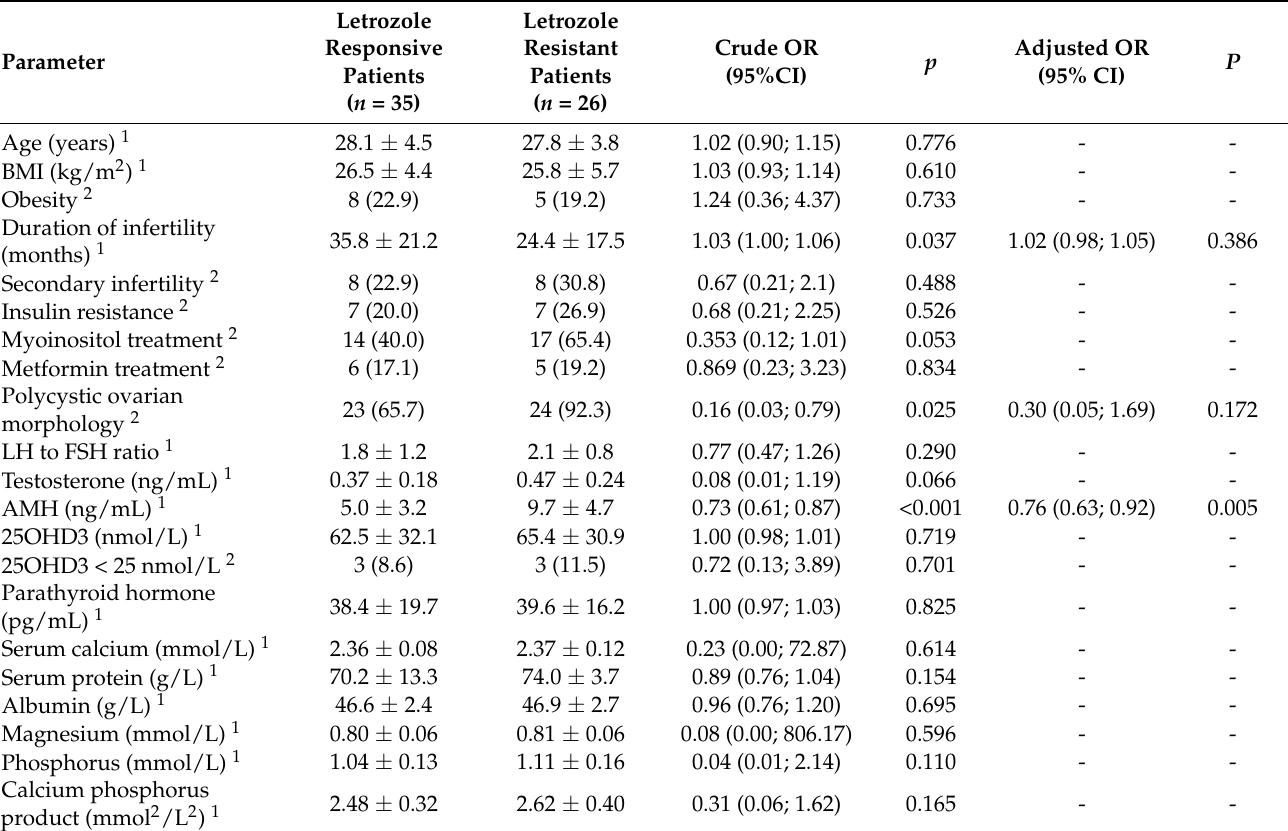
Table 2. Univariate followed by multivariate binary regression model for the prediction of follicle maturation after letrozole